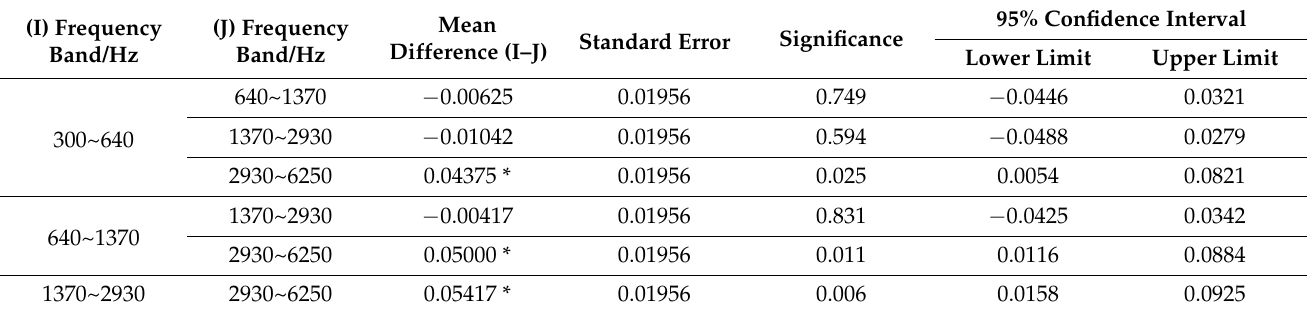
Table 4. The LSD Analysis of Frequency